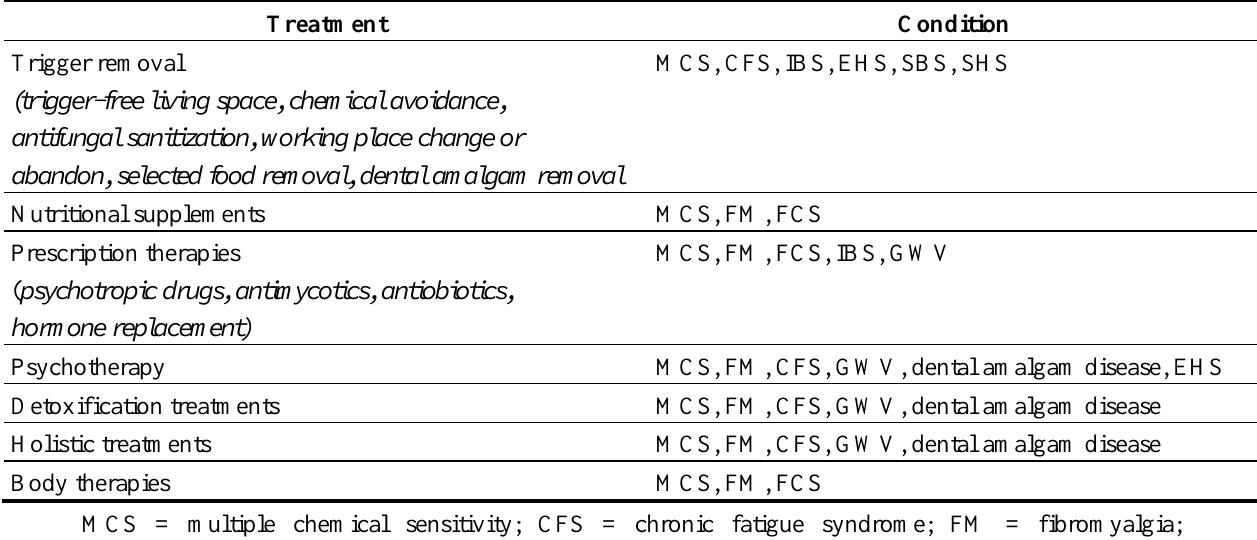
Table 2. Main categories of treatments (including non-conventional and self-prescription) reported for environmental